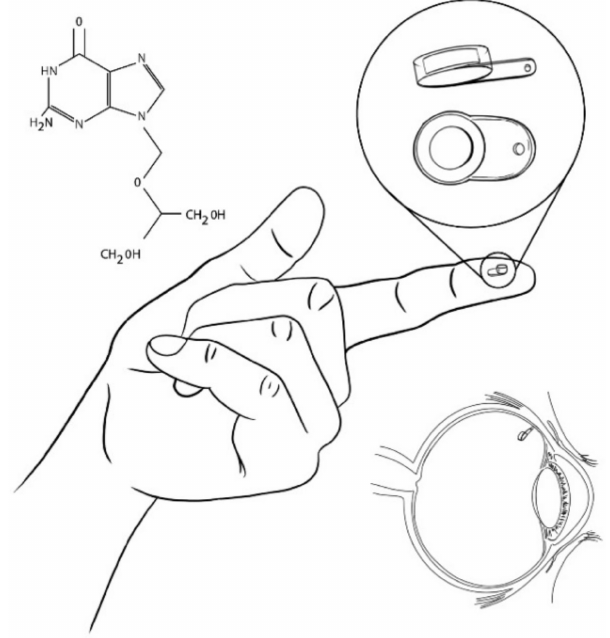
Figure 2. Vitrasert (Ganciclovir-loaded